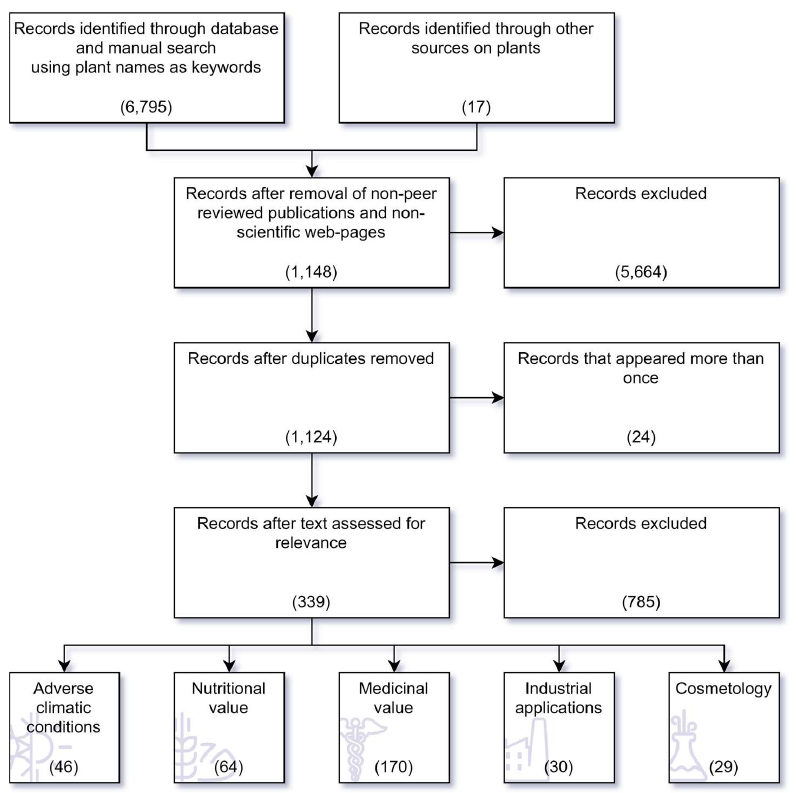
Figure 3. Diagram of the PRISMA method to search for resistance to adverse conditions for native plants and for added values: nutritional, medical, industrial, cosmetology and dye use.